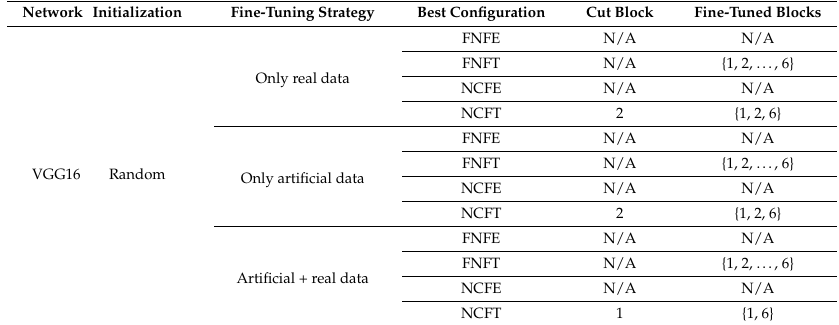
Table 5. The best neural network configurations applied to VGG16, ResNet50, and Inception-v3 were analyzed by two weights initializations: ImageNet and random (trained from